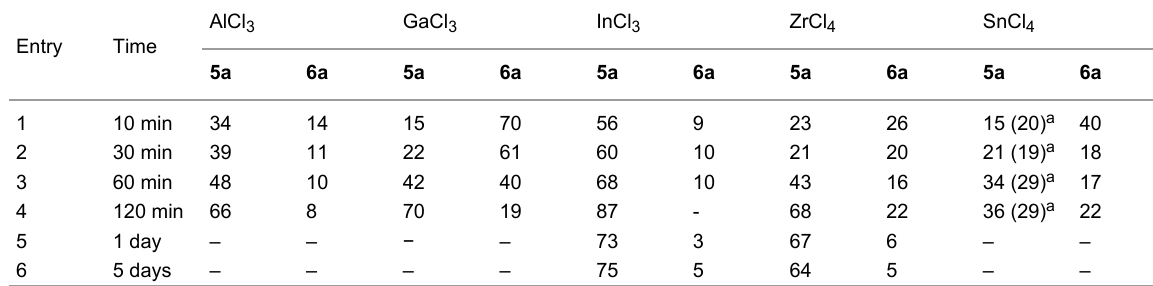
Table 4: Time dependency of domino aldol reactions in the presence of various metal chlorides (reaction temperature: 25 °C, 5a / 6a in %).